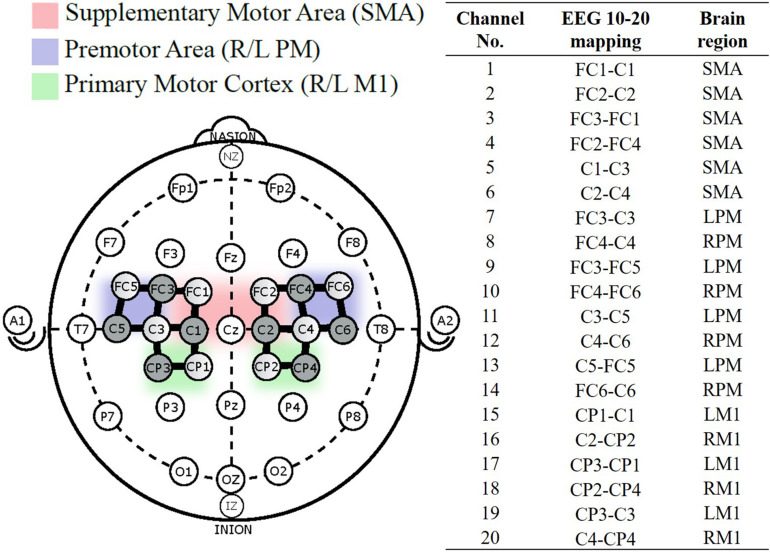
fNIRS probe placement based on the international 10–20 system, with 8-sources (shaded), 8-detectors (unshaded), and 20 channels (solid black line) between them. Channel numbered 1–20 were divided into five regions of interest (Cao et al., 2015).